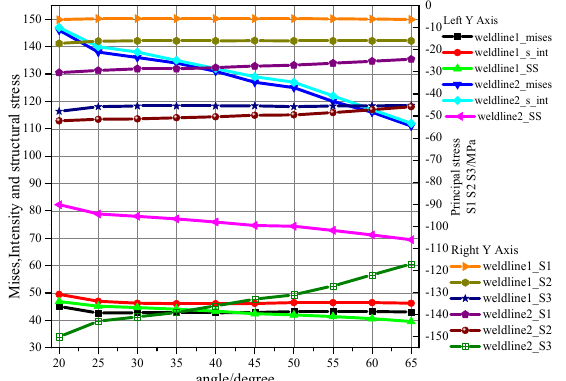
Figure 21. Trends of various stresses with the groove angle.